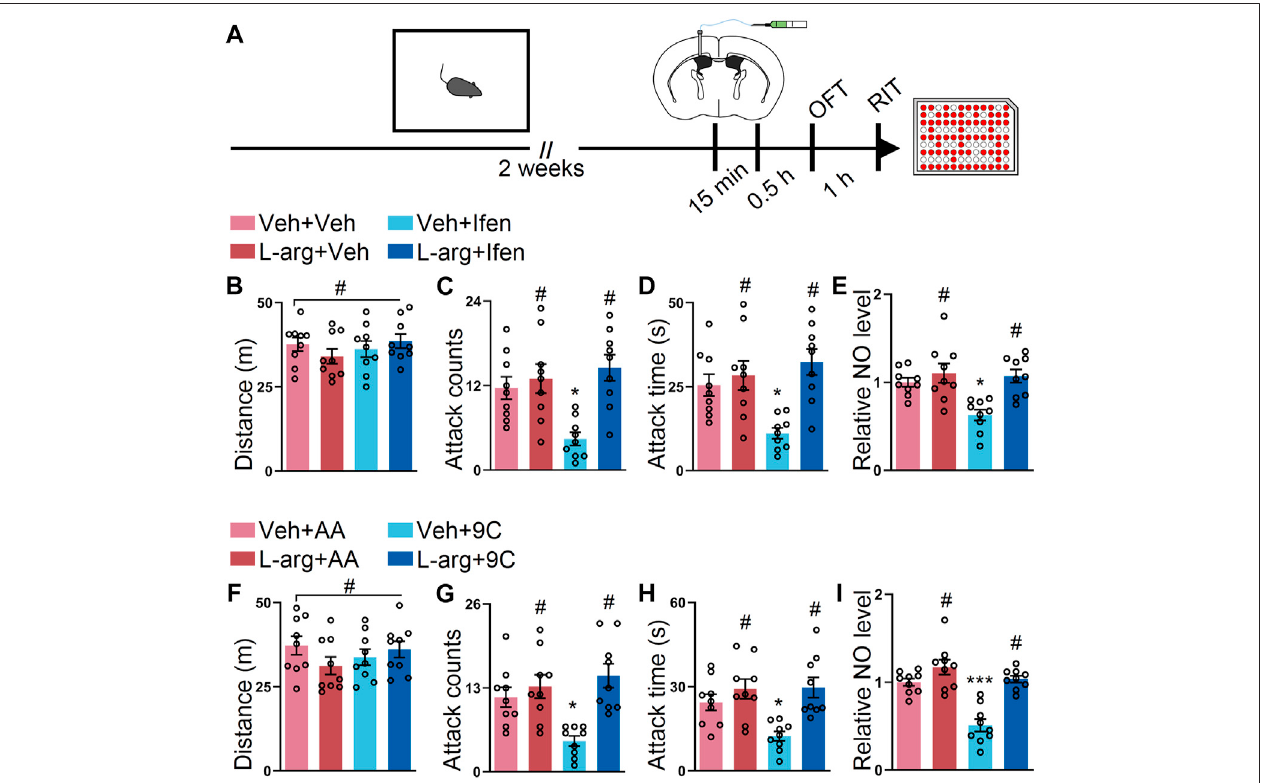
FIGURE 4 | L-arginine reversed the effect provided by blockade of GluN2B on the SI-induced exacerbated attack behavior. (A) Schematic diagram of the experimental procedure for behavioral tests and NO detection. The mice were implanted with a guide cannula and singly housed for 2 weeks. Afterward, L-arginine (L-arg) and ifenprodil or L-arginine and TAT peptide were injected via the ICV route, and behavioral tests were performed. (B) Total distance of the mice that received